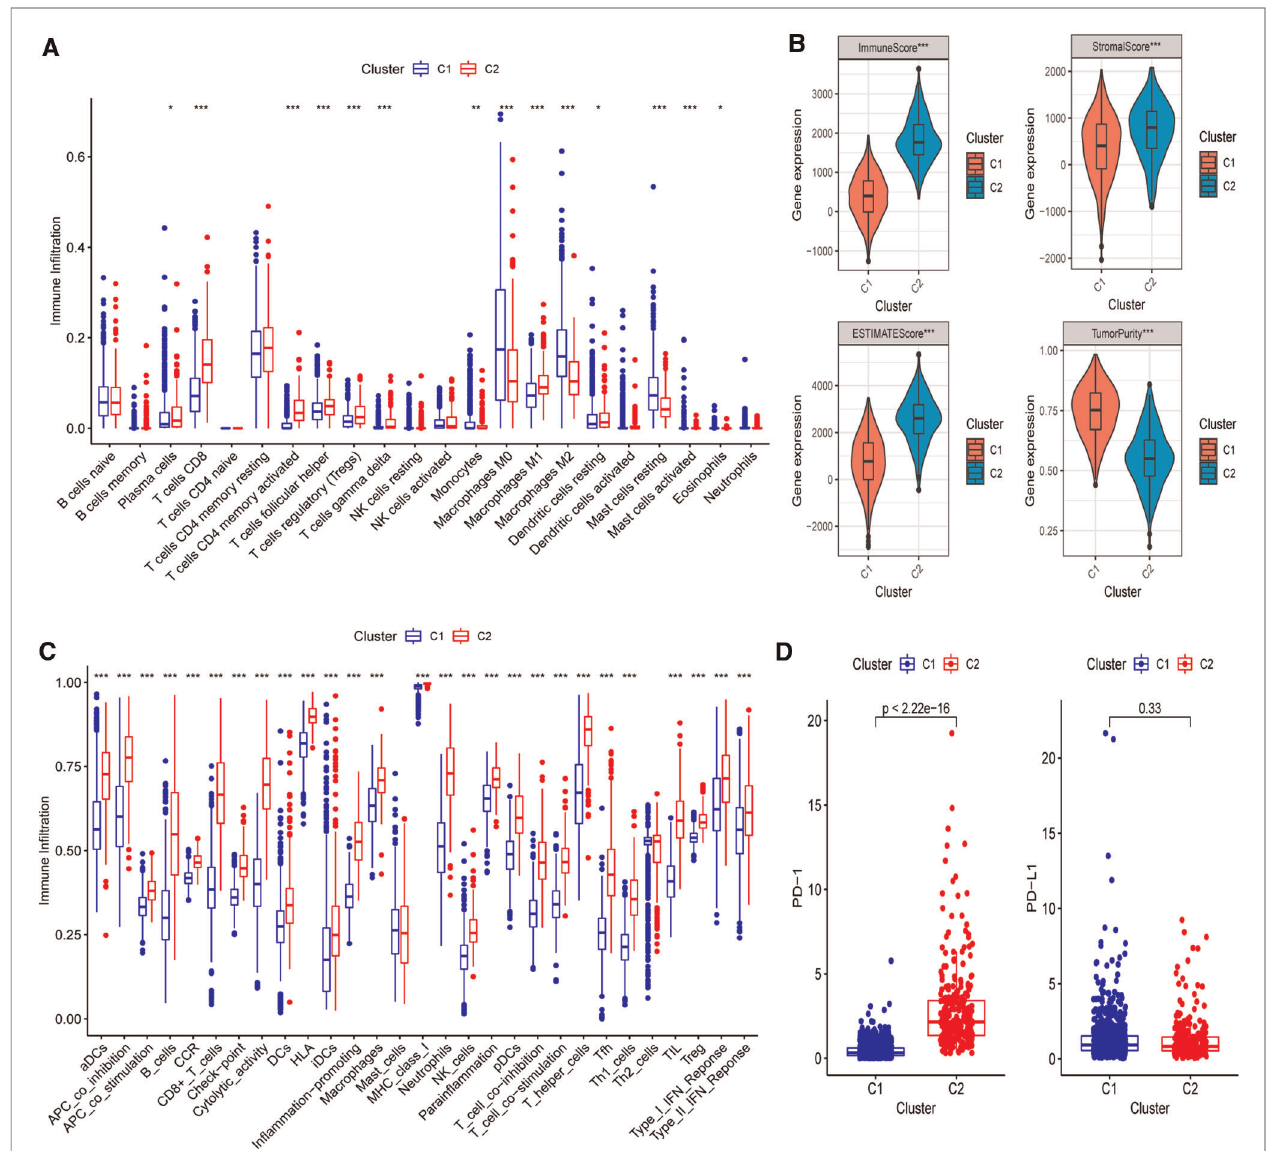
FIGURE 3 | Differences of immuno-in fi ltrative features between two PR clusters. ( A ) Levels of 22 immunocytes calculated with CIBERSORT in two clusters. ( B ) Levels of ImmuneScore, StromalScore, ESTIMATEScore, and TumorPurtiy calculated with ESTIMATE in the two PR clusters. ( C ) Differences of single-sample gene set enrichment analysis (ssGSEA) scores between two PR clusters. ( D ) Expression of PD-1 and PD-L1 in two PR clusters. * p <0.05, ** p <0.01, *** p <0.001, ns, not signi fi